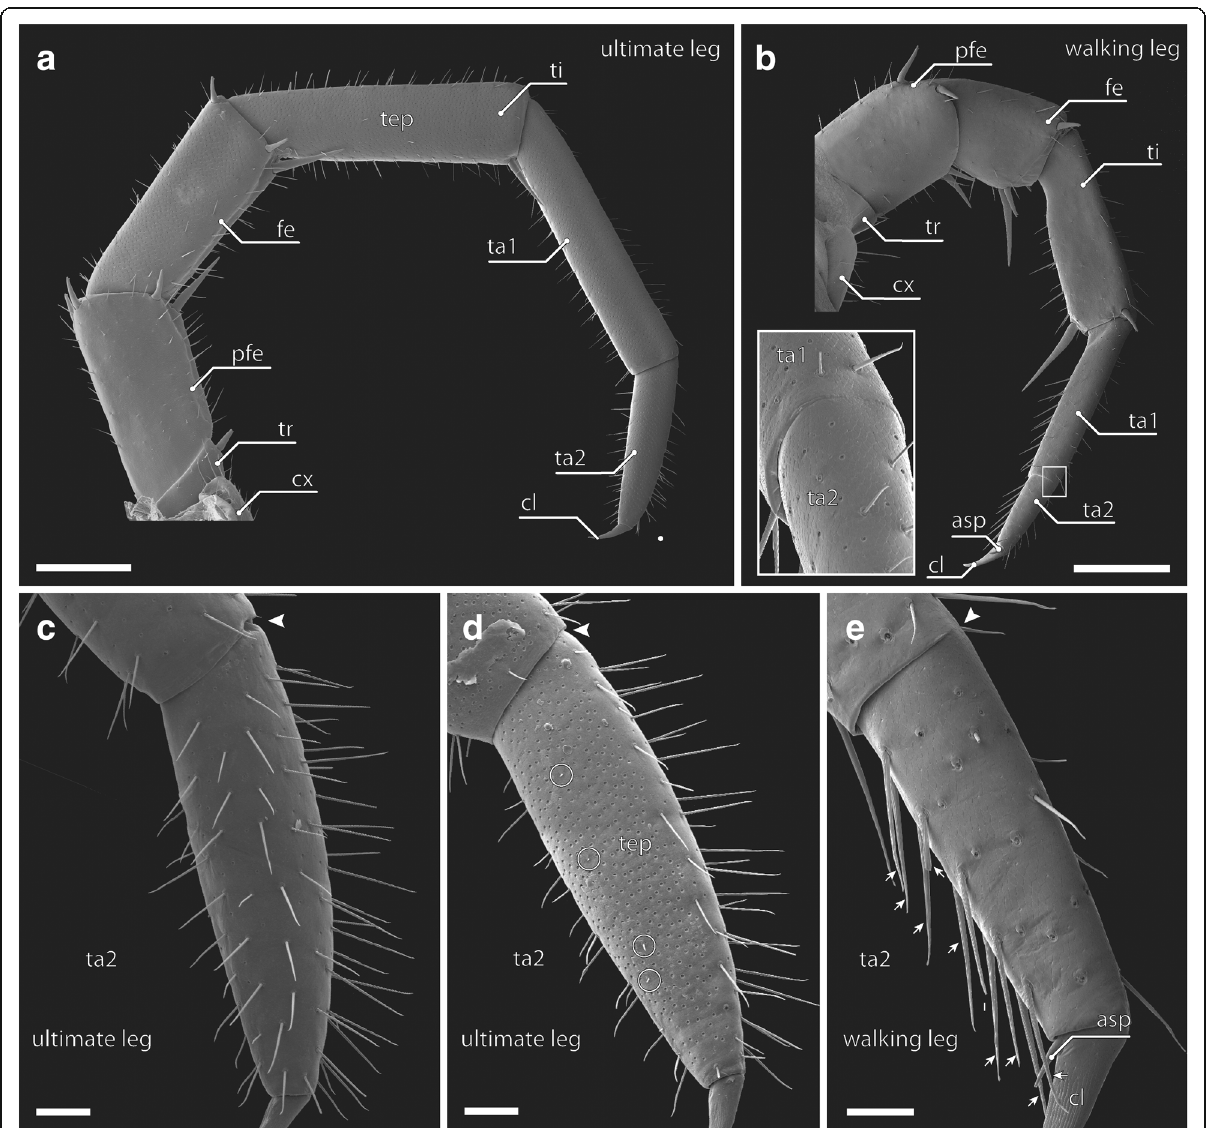
Fig. 2 External morphology of walking and ultimate leg. a Overview of ultimate leg, from medial. Scale bar 500 μ m. b Overview of walking leg 10, from medial. Note that only the walking leg features an accessory spine on the claw (asp, compare e ). Inset shows the dorsally incomplete tarsal articulation of walking legs (compare d – e ). Scale bar 500 μ m. c Ultimate leg tarsus 2 from lateral. The arrowhead indicates the complete tarsal articulation. Scale bar 100 μ m. d Ultimate leg tarsus 2 from medial. Pores of the telopodal organs (tep) cover the entire medial surface. Note the four sensilla mesotrichodea II interspersed between the telopodal gland pores (circles). The arrowhead indicates the complete tarsal articulation (compare c , d ). Scale bar 100 μ m. e Tarsi of walking leg 10, from medial. The arrowhead indicates the incomplete articulation of the tarsi. Arrows point to s. macrotrichodea II that are only present on the ventral side of walking leg tarsus 1 (compare Figs. 5 and 6h). Scale bar 50 μ m. Abbreviations: asp accessory spine, cl claw, cx coxa, fe femur, pfe prefemur, ta tarsus, tep telopodal gland pores, ti tibia, tr